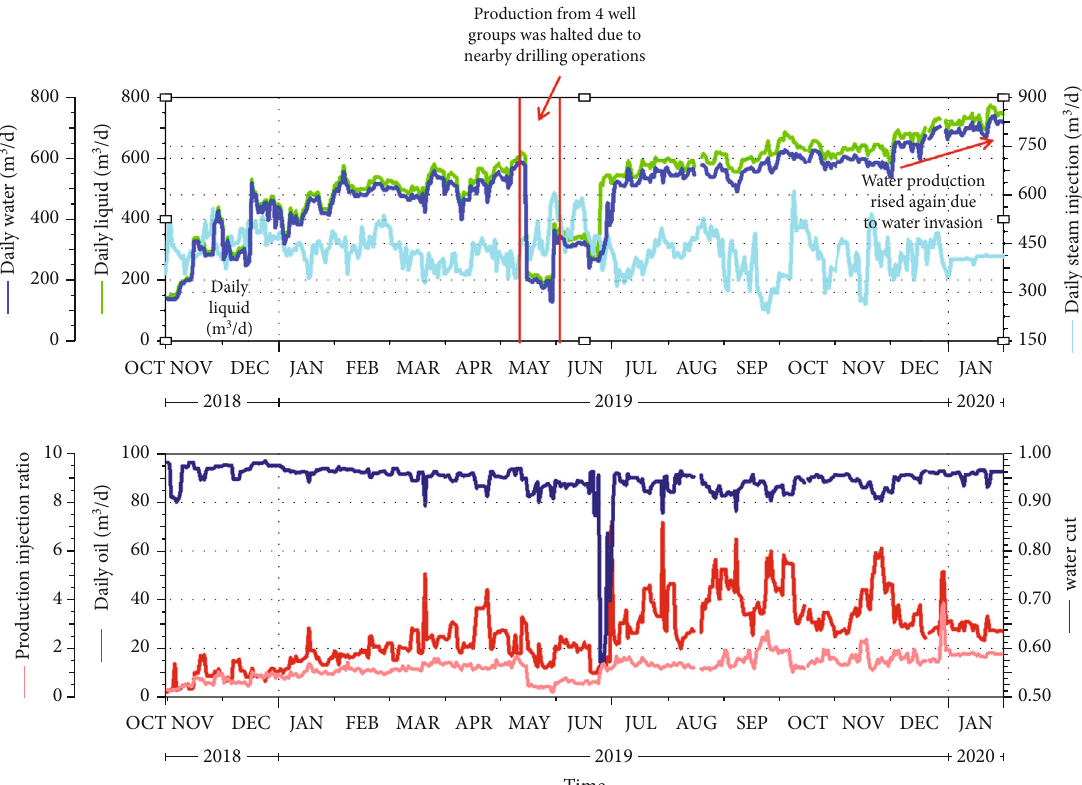
Figure 10: Production pro fi les of the test area in response to CO